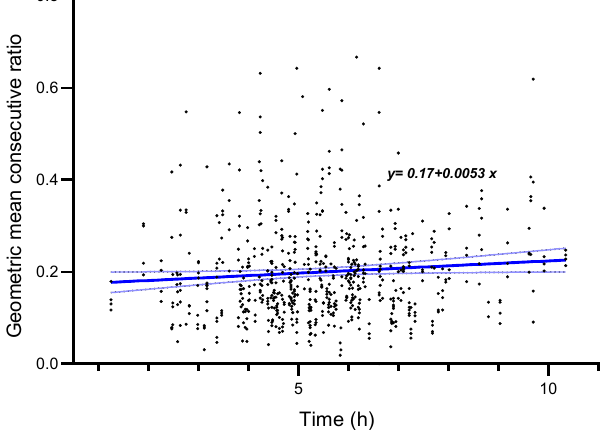
Figure 6. Effect of surgery time on geometric mean consecutive ratio of mTc-MEP amplitudes. The x -axis denotes the time of surgery in hours, and the y-axis denotes the geometric mean consecutive ratio. The blue line is the fitted linear regression line, and the corresponding formula of the line is stated in the figure. Time of surgery in hours was significantly associated with the geometric mean consecutive ratio ( p = 0.04).